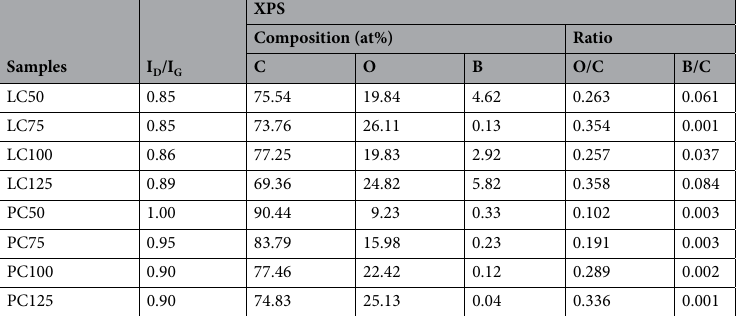
Table 1. Intensity ratio of D and G bands (I D /I G ) from Raman spectroscopy, and surface element compositions and doping concentration from XPS measurement of LC and PC synthesized from TBB via SP at frequencies of 50, 75, 100 and 125 kHz for 60 min (Note: at% means atomic percent).